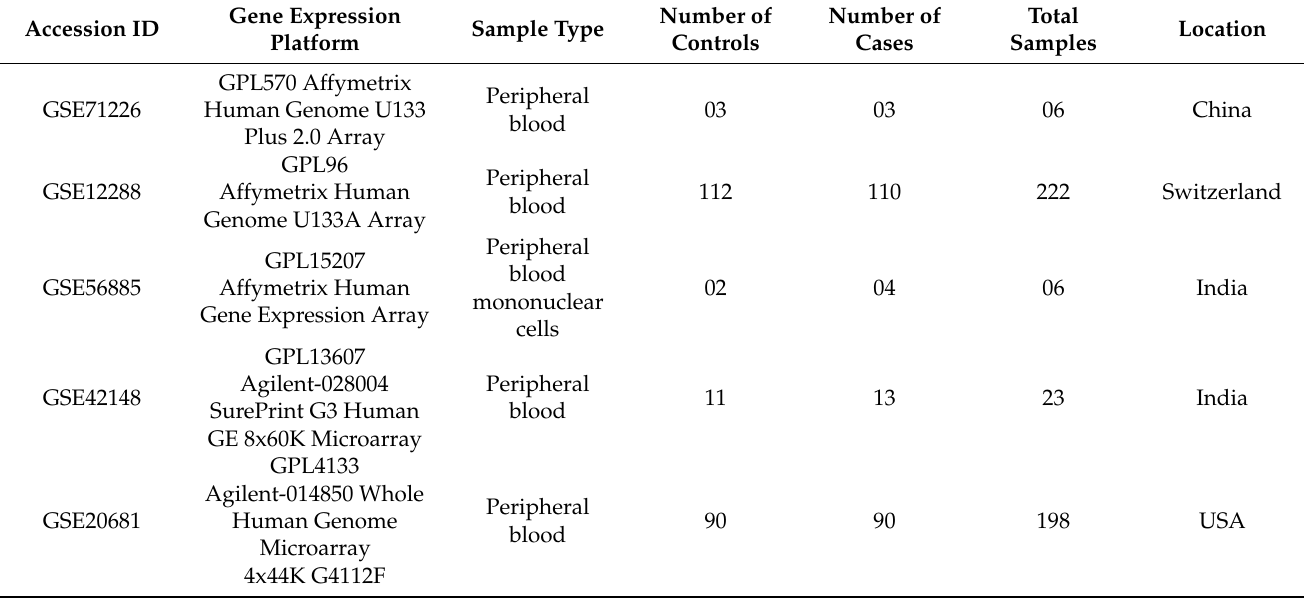
Table 1. Selected experiments and their